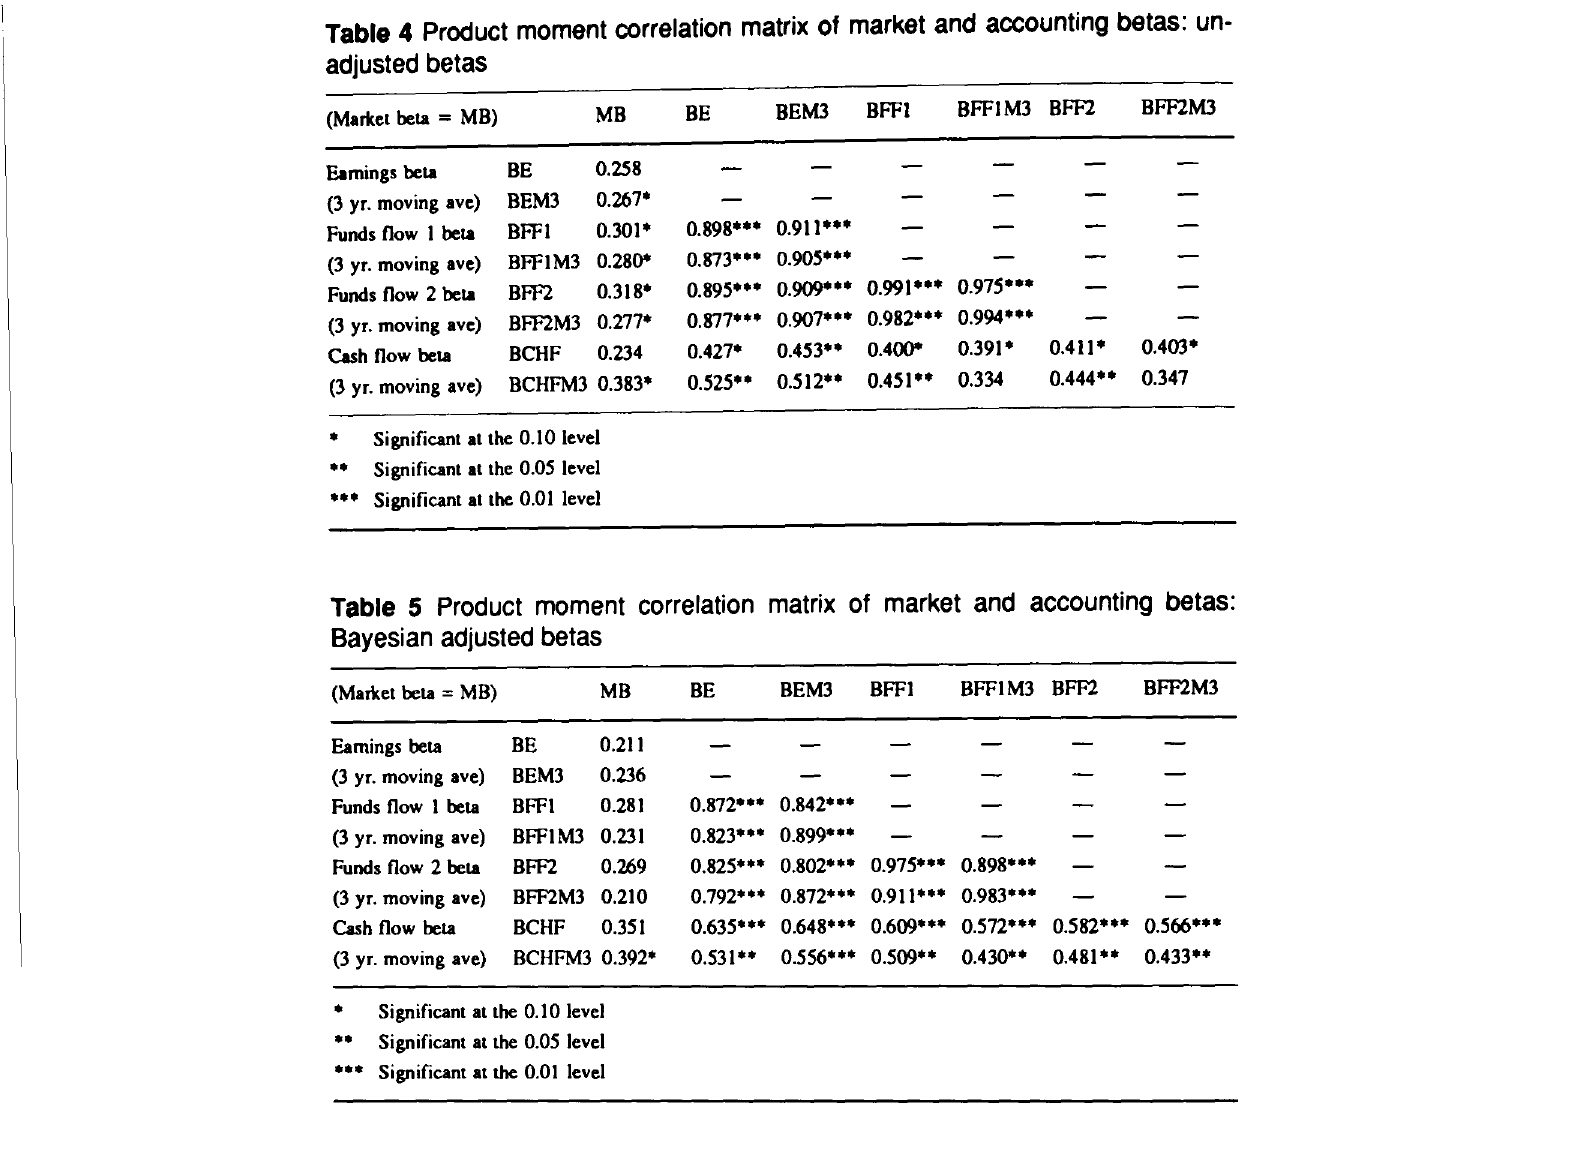
Table 5 Product moment correlation matrix of market and accounting betas: Bayesian adjusted